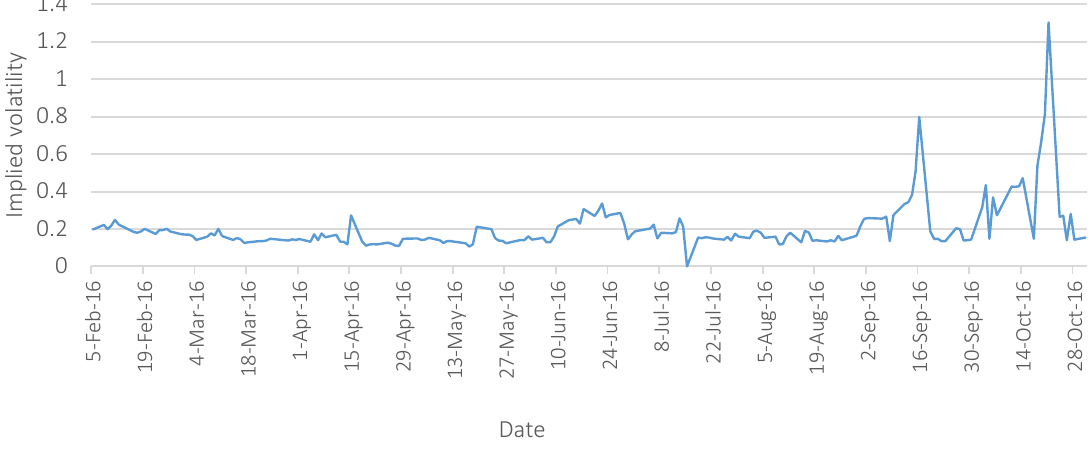
Figure 2. Implied volatility (IV) values in February – October